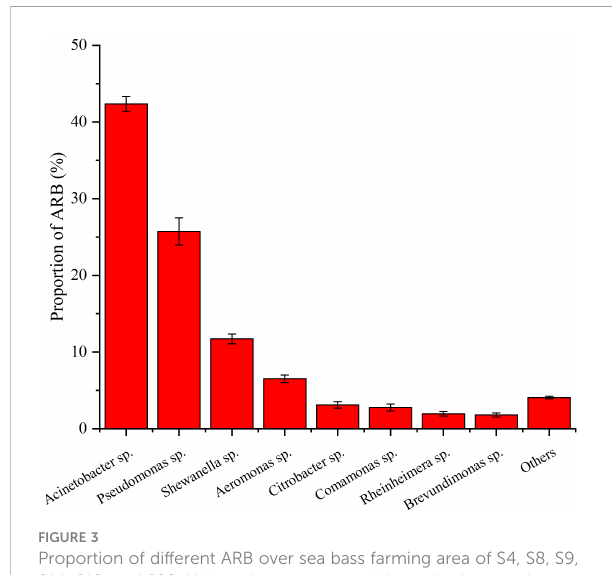
FIGURE 3 Proportion of different ARB over sea bass farming area of S4, S8, S9, S14, S18, and S20. Values show means and 1 standard error of mean (mean ± SEM, n = 6).